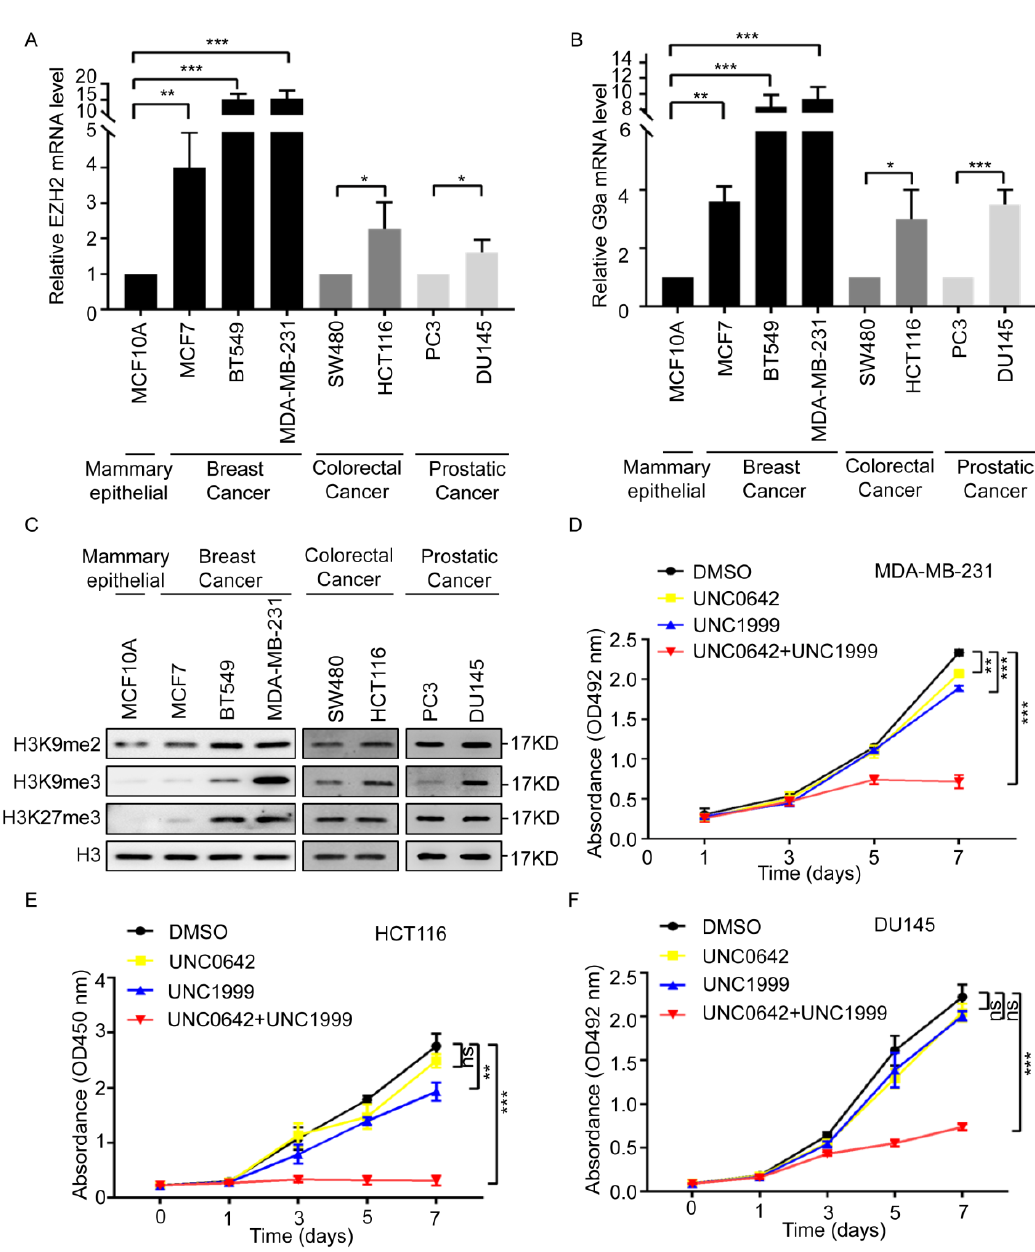
Figure 1. A combination of UNC0642 and UNC1999 inhibits the proliferation and migration of tumor cells. ( A ) qRT-PCR analysis of the expression of EZH2 in noncancerous mammary epithelial cell (MCF10A) and breast cancer cells (MCF7, BT549, and MDA-MB-231), colon cancer cells (SW480 and HCT116) and prostate cancer cells (PC3 and DU145). ( B ) qRT-PCR analysis of the expression of G9a in noncancerous mammary epithelial cell (MCF10A) and breast cancer cells (MCF7, BT549, and MDA-MB-231), colon cancer cells (SW480 and HCT116), prostate cancer cells (PC3 and DU145). ( C ) Western blot analysis of expression of H3K9me2, H3K9me3, and H3K27me3 in noncancerous mammary epithelial cell (MCF10A) and breast cancer cells (MCF7, BT549, and MDA-MB-231), colon cancer cells (SW480 and HCT116), and prostate cancer cells (PC3 and DU145). ( D – F ) MTT or CCK8 assay was performed to detect the proliferation of MDA-MB-231 cells ( D ), HCT116 cells ( E ), and DU145 cells ( F ) treated with indicated treatments for seven days. Each experiment was repeated at least three times. Error bars, mean ± SD, ns: no significant, * p < 0.05, ** p < 0.01, *** p <